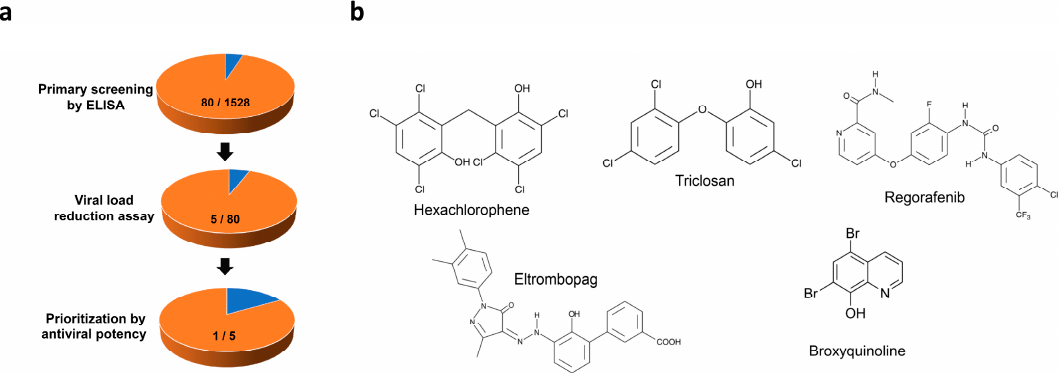
Figure 2. Identification of anti-SFTSV drug compounds. ( a ) Screening pipeline and attrition rates of compounds from primary screening by ELISA, secondary screening by viral load reduction assay, followed by prioritization by IC 99 . ( b ) Shown are chemical structures of five selected drugs that show dose-dependent inhibition of SFTSV replication.